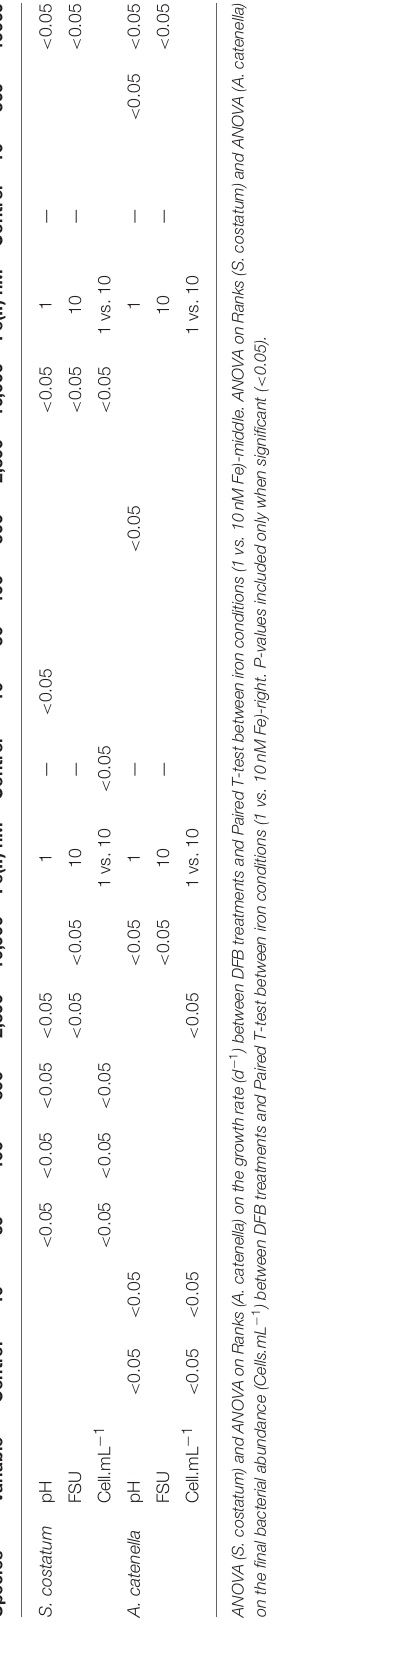
the experiment, the bacterial abundance at 10,000 nM DFB